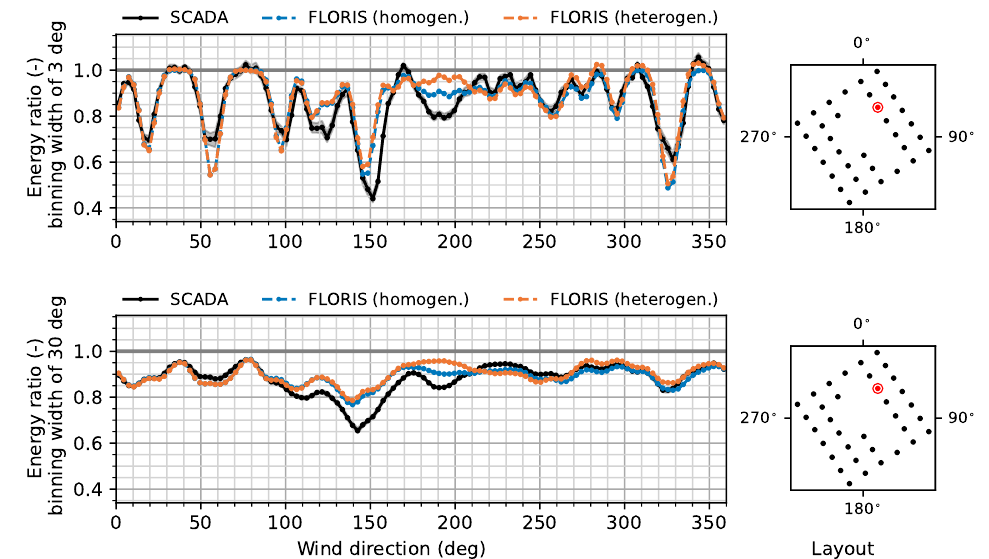
Figure 15. Energy ratio curves for Turbine 25 in the Westermost Rough wind farm, where the reference turbines are all upstream turbines within a 5 km radius, and the reference wind direction is the average of the nacelle headings of Turbines 24, 27, 32, and 33. The shaded regions represent 90% confidence intervals obtained through bootstrapping. The layout schematic on the right shows the location of Turbine 25 in the wind